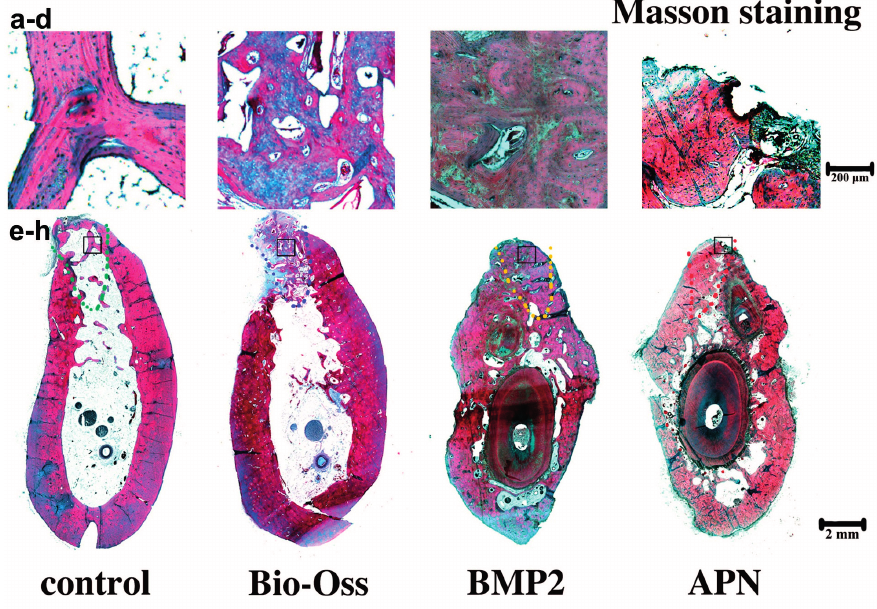
Figure 5. Decalcified toluidine Masson staining of extraction sockets following the different 12-week treatments: ( a ) The magnifying control group; ( b ) Bio-Oss group; ( c ) BMP2 group; ( d ) APN group; ( e – h ) represent the integral extraction socket of control group ( e ); Bio-Oss group ( f ); BMP2 group ( g ); APN group ( h ). The black square represents the magnifying area. The dashed line represents the extraction sockets. New new bone is shown in red. Magnification: upper panel 40×; lower panel 4×. n = 4 for each